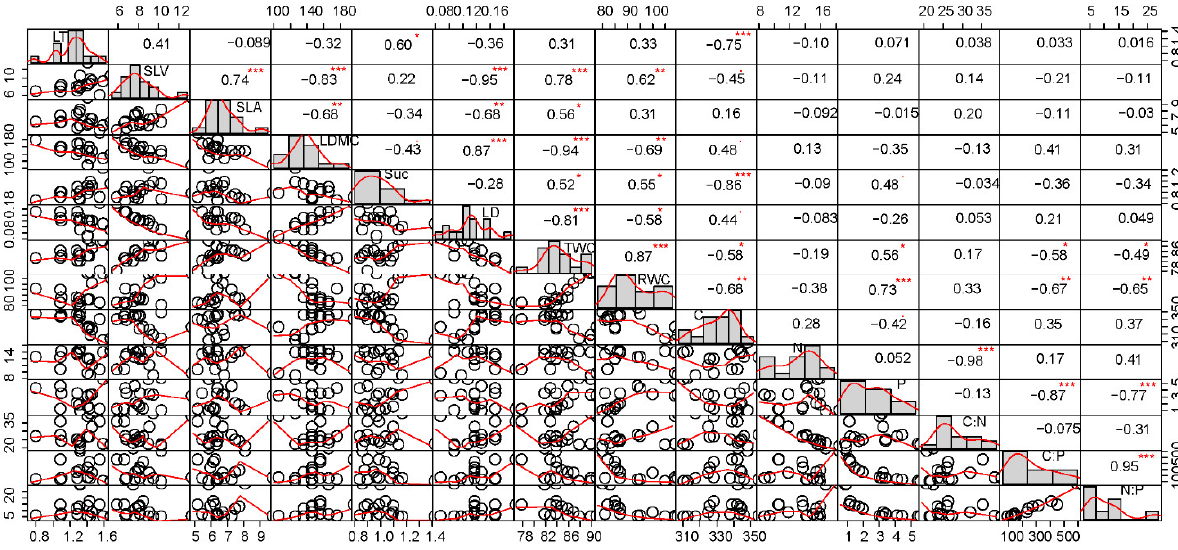
Figure 2. Correlation analysis among leaf functional traits and water-salt response. Drawing using R “Performance Analytics” package. The numbers in the upper triangular region of the graph indicate correlation coefficients and the asterisks indicate significance. The lower triangle is a linear regression between the two traits. LT: leaf thickness (mm), SLA: specific leaf area (mm 2 mg −1 ), SLV: specific leaf volume (cm 3 g −1 ), LDMC: leaf dry matter content (mg g −1 ); Suc: succulence (g cm −2 ); LD: leaf dry matter concentration (g cm −3 ), TWC: total water content (%), RWC: relative water content (%), C: organic matter content (g kg −1 ), N: nitrogen content (g kg −1 ), P: phosphorus content (g kg −1 ), C:N: the ratio of C and N, C:P: the ratio of C and P, N:P: the ratio of N and P.